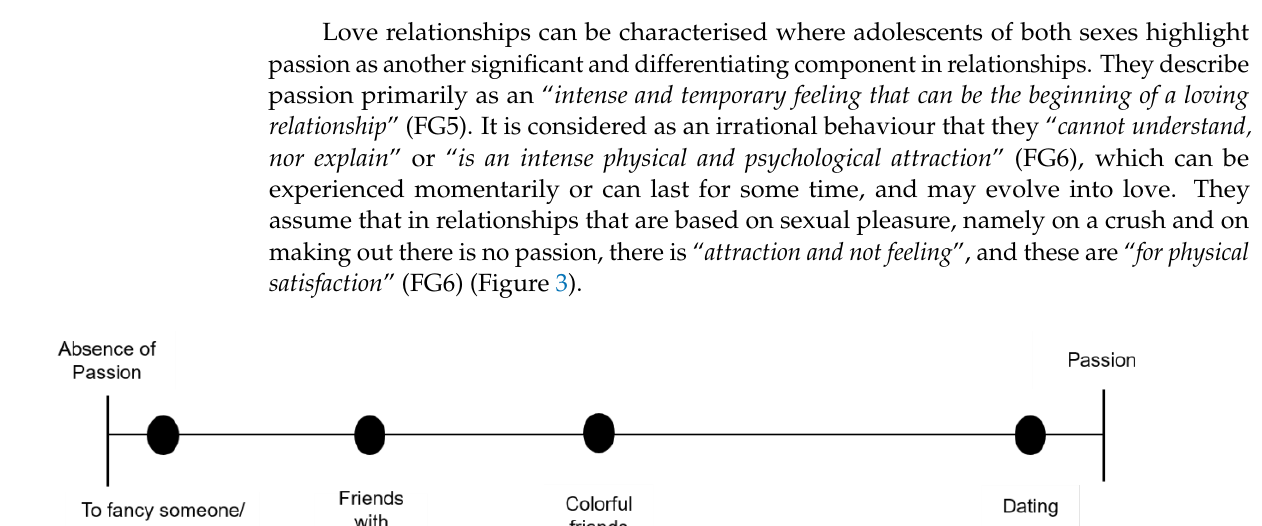
Figure 2. Spectrum of the representation of intimacy in love relationships between adolescents.